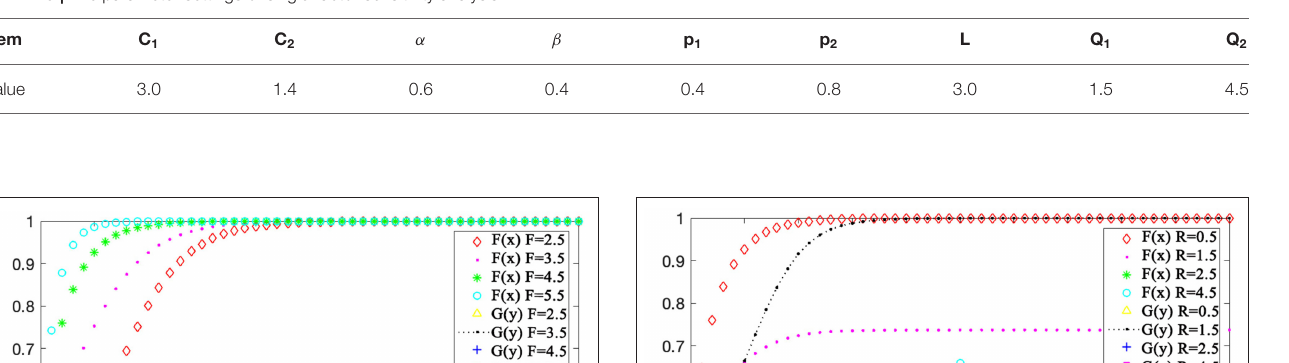
TABLE 6 | The parameter settings of single-factor sensitivity analysis.